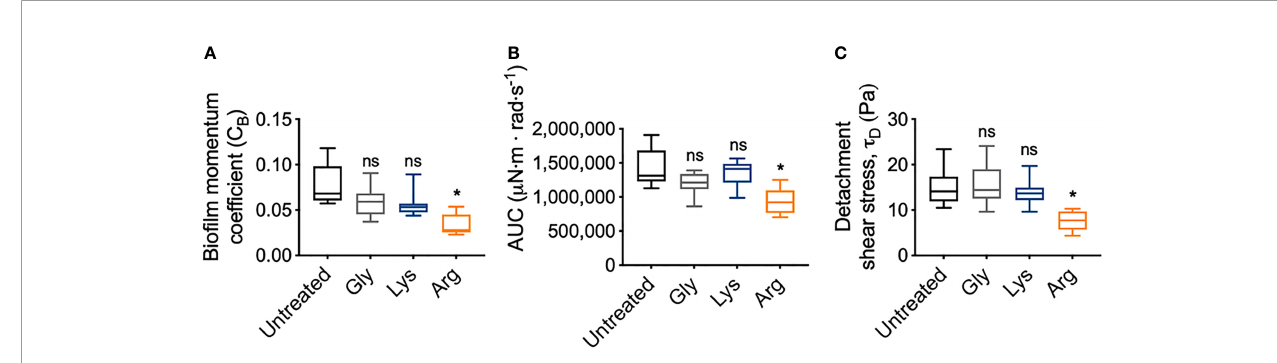
FIGURE 6 | Arginine treatment weakens S. gordonii bio fi lms. (A) Bio fi lm momentum coef fi cient ( C B ), determined according to equation 1, at 200 – 300 rad.s -1 in Figure 3 [Range; Untreated: 0.057 – 0.118; glycine: 0.037 – 0.091; lysine: 0.044 – 0.089; arginine: 0.023 – 0.054]. (B) Area under the curve (AUC) of torque – angular velocity curves depicted in Figure 3 [Range; Untreated: 1,126,923 – 1,909,471; glycine: 863,187 – 1,390,189; lysine: 986,807 – 1,564,073; arginine: 702,523 – 1,250,791 m N·m · rad·s -1 ]. (C) Initiation of detachment, indicated as the fi rst reduction in torque in Figures 3 , converted to shear stress according to equ 3 [Range; Untreated: 10.50 – 23.50; glycine: 9.61 – 24.10; lysine: 9.61 – 19.70; arginine: 4.34 – 10.30 Pa]. * p-value < 0.05, ns indicates no statistical